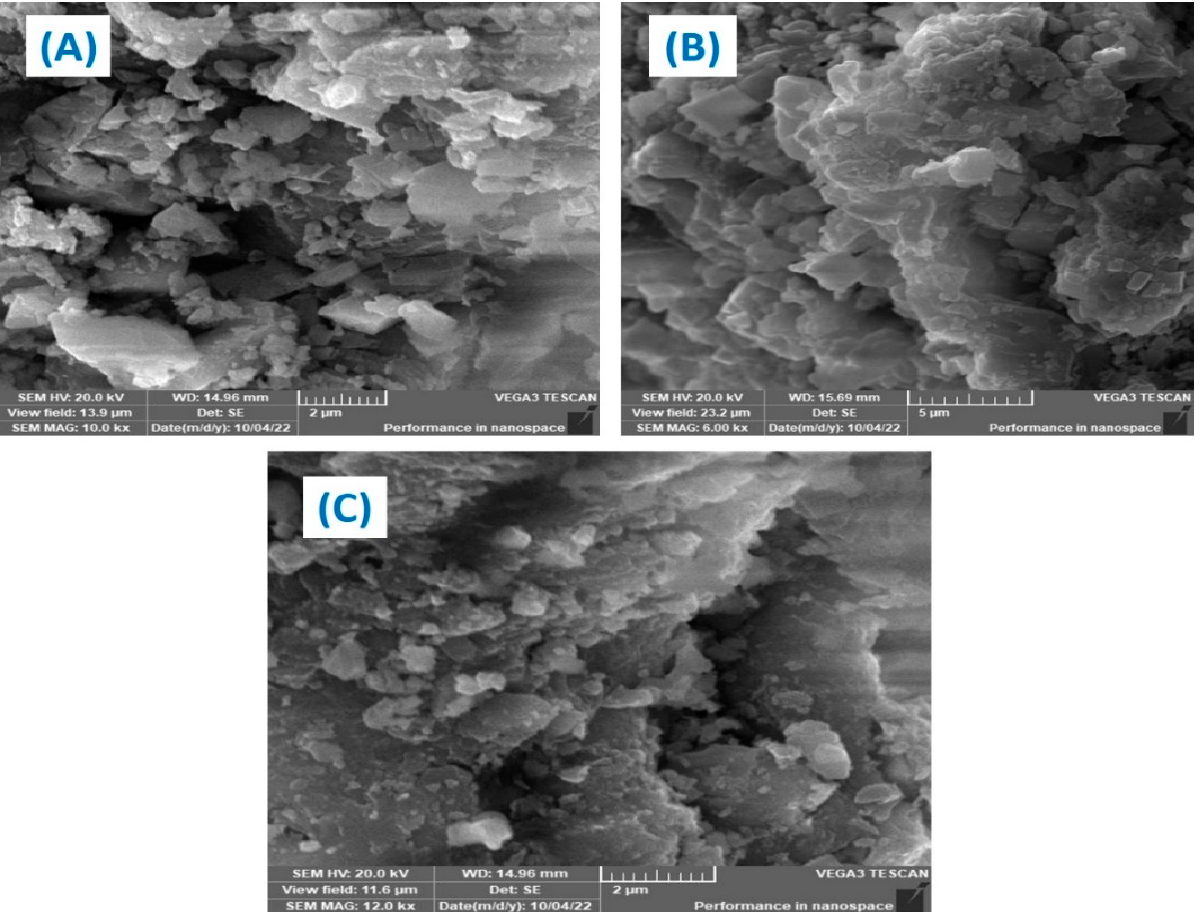
Figure 3. SEM of ( A ) Fe–Cu/Alg–LS nanocomposite, ( B ) Fe–Cu/Alg–LS—loaded CIP, ( C ) Fe–Cu/Alg– LS—loaded